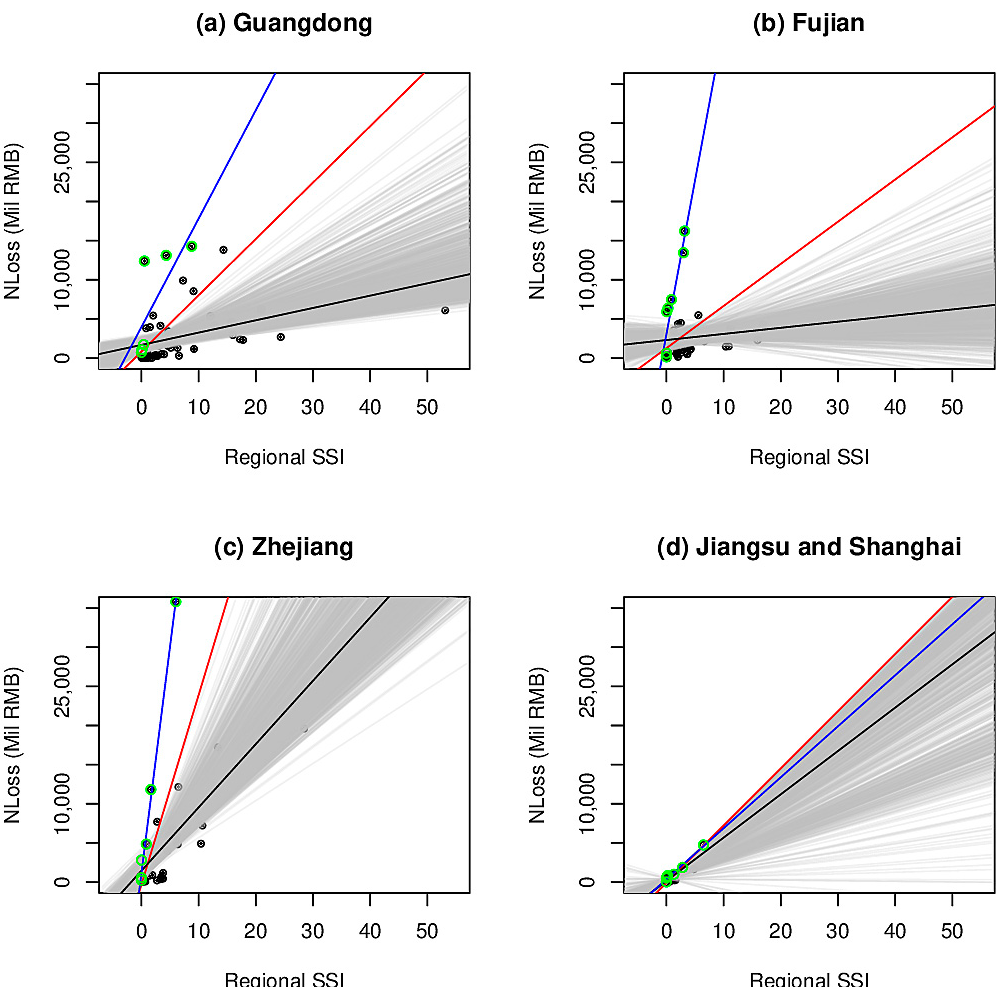
Figure 6. Relationship between regional SSI and NLoss of TC events in the period of 1999–2018. Black lines indicate the regression lines derived using the full data set (black dots). Grey lines indicate the regression lines of the sensitivity experiment. Red lines indicate the regression line with the steepest slope in the sensitivity experiment. Blue lines indicate the maximum potential loss which are derived using selected data points as indicated by green dots. See main text for detailed explanation.